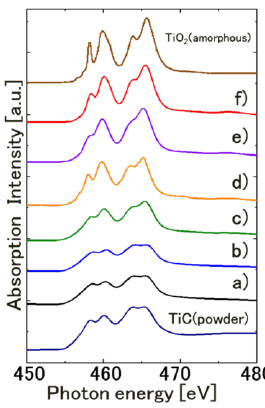
Figure 8. NEXAFS spectra of the Ti L -edge, before and after exposure to atomic oxygen. Fluences of atomic oxygen beam are ( a ) 0 atoms cm −2 , ( b ) 1.2 × 10 17 atoms cm −2 , ( c ) 1.2 × 10 18 atoms cm −2 , ( d ) 3.5 × 10 18 atoms cm −2 , ( e ) 1.2 × 10 19 atoms cm −2 , and ( f ) 1.9 × 10 20 atoms cm −2 . The spectra of TiC powder and TiO 2 amorphous are also shown for reference.